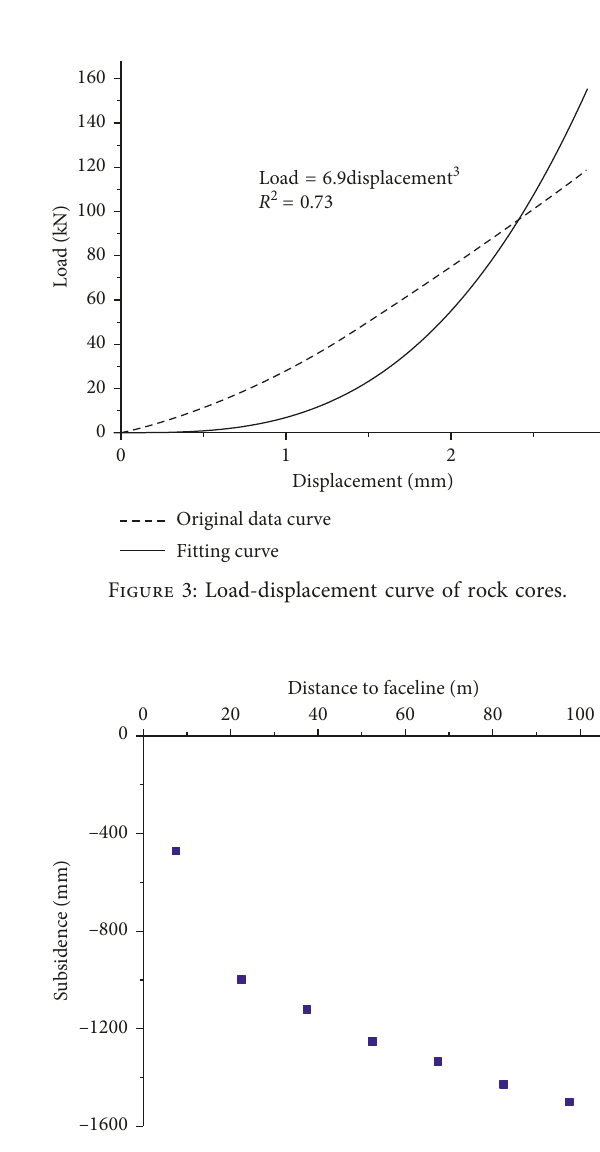
Figure 4: Relative subsidence of the voussoir beam structure above the mined-out